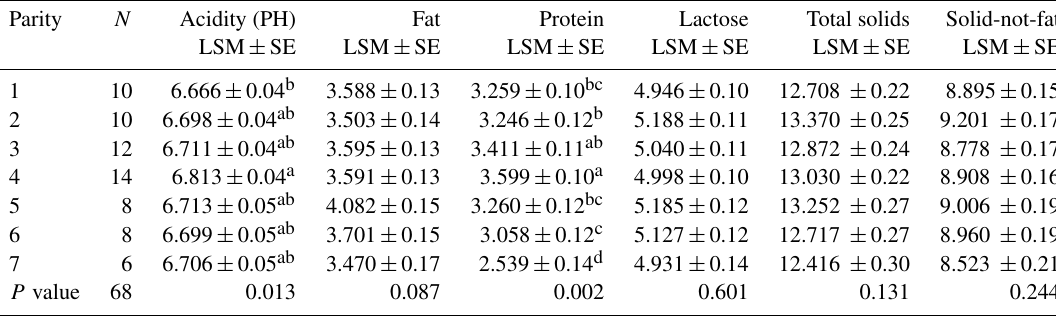
Table 3. Effect of parity on milk chemical compositions (%) in Maghrebi camels. Parity N Acidity (PH) Fat Protein